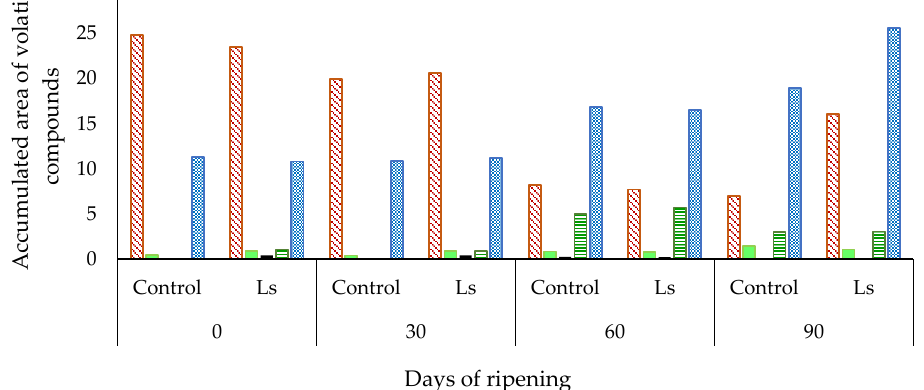
Figure 1. Accumulated area of volatile ( × 10 6 ) compounds according to their origin, throughout the ripening of dry-cured fermented “salchich ó n” in Control and Ls (inoculated with Lactilactobacillus sakei ) batches.